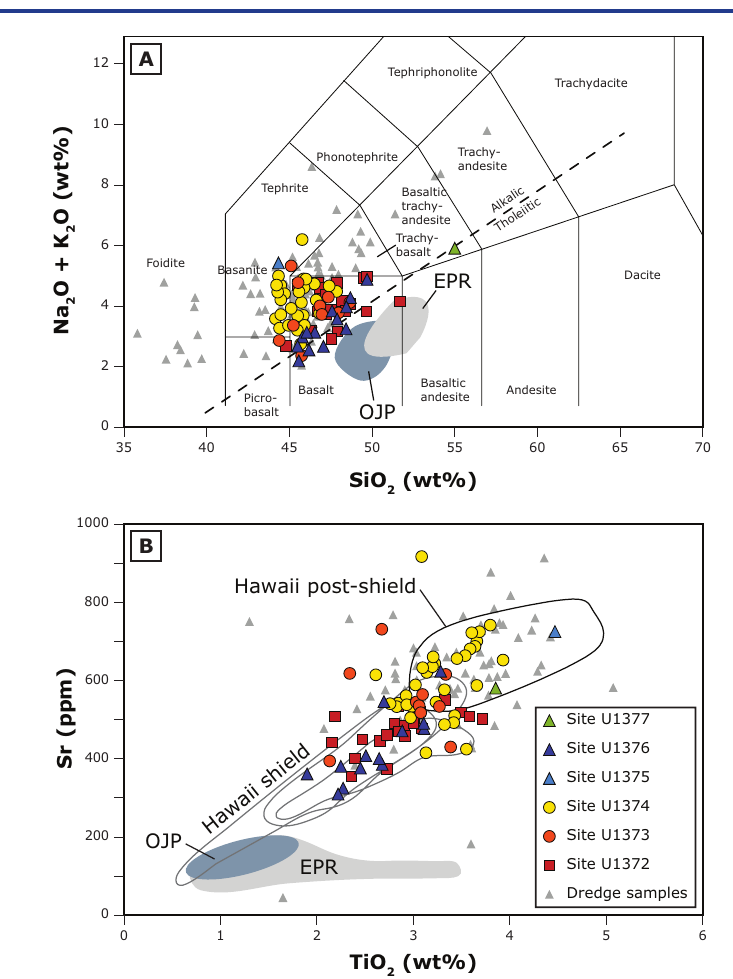
Figure 6. Compilation of shipboard geochemistry data. [A] Total alkalis vs. silica of Bas et al. (1986) with division of alkaline vs. subalkaline (tholeiitic) series from Macdonald and Katsura (1964), showing an absence of tholeiitic rocks in the current sample suites for the Louisville seamount trail. [B] TiO 2 vs. Sr compared against Figure fields for several Hawaiian volcanoes (in gray-black outlines) distinguishing “Hawaii shield” from “Hawaii post-shield” volcanism. Also shown are fields for the southern East Pacific Rise (EPR) and Ontong Java Plateau (OJP). Dredge sample data include samples with Loss of Ignition (LOI) <6 wt% only (Beier et al., 2011; Hawkins et al., 1987; Vanderkluysen et al., 2007). All major element data are normalized to 100 wt% totals. Figure after Koppers et al. (2012a).